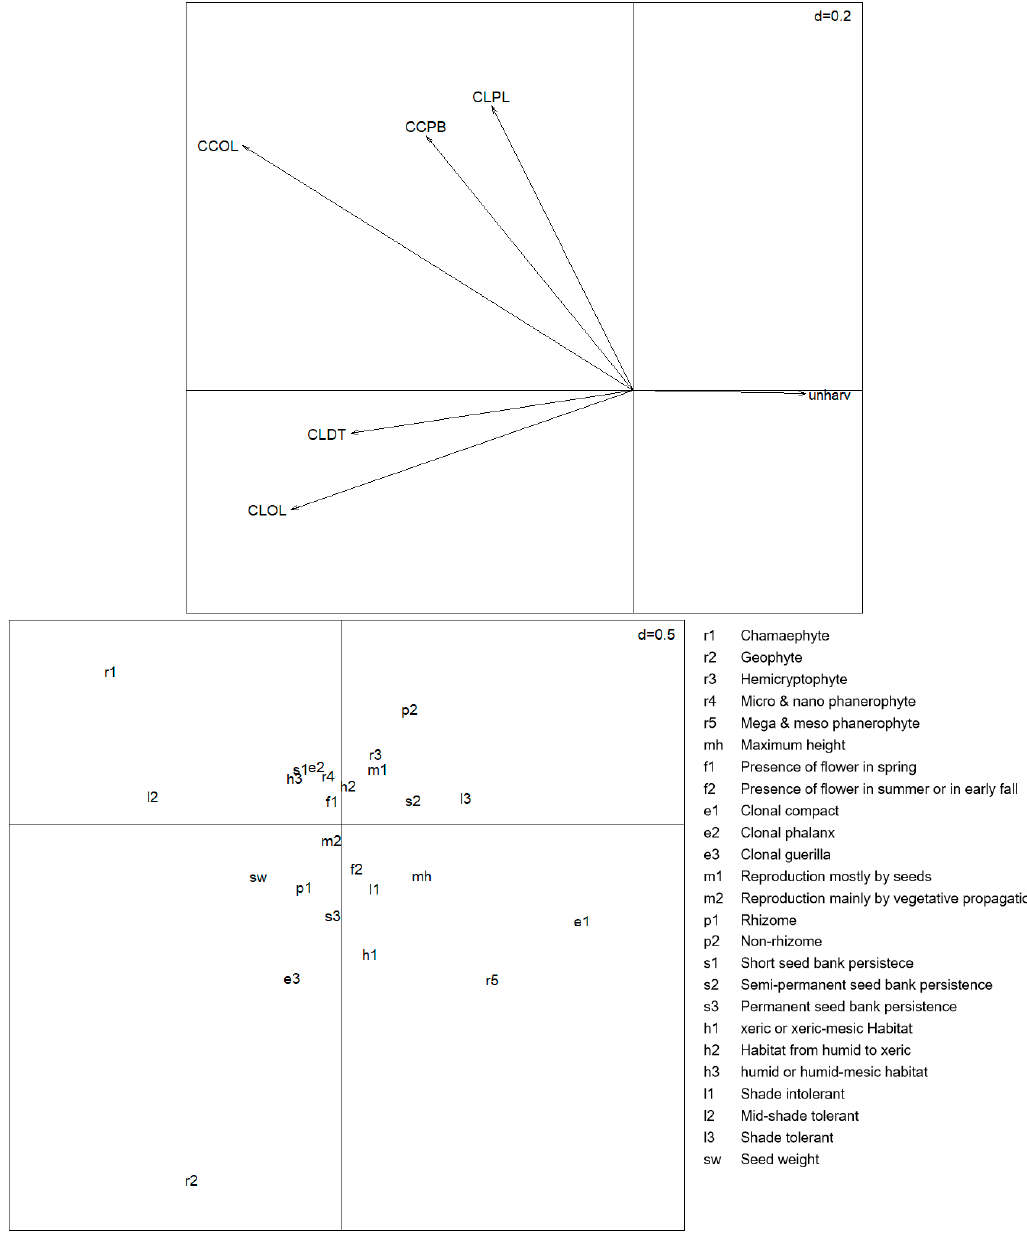
Figure 3. Result of basic RLQ indicating different combinations of retention pattern and site preparation (left), and trait groups (right) along the first two axes. unharv: unharvest, CLOL: careful logging only, CCOL: clear cut only, CLPL: plowing after careful logging, CLDT: disk trenching after careful logging, CCPB: prescribed burning after clear cut. Abbreviations for traits are defined in Table 3.